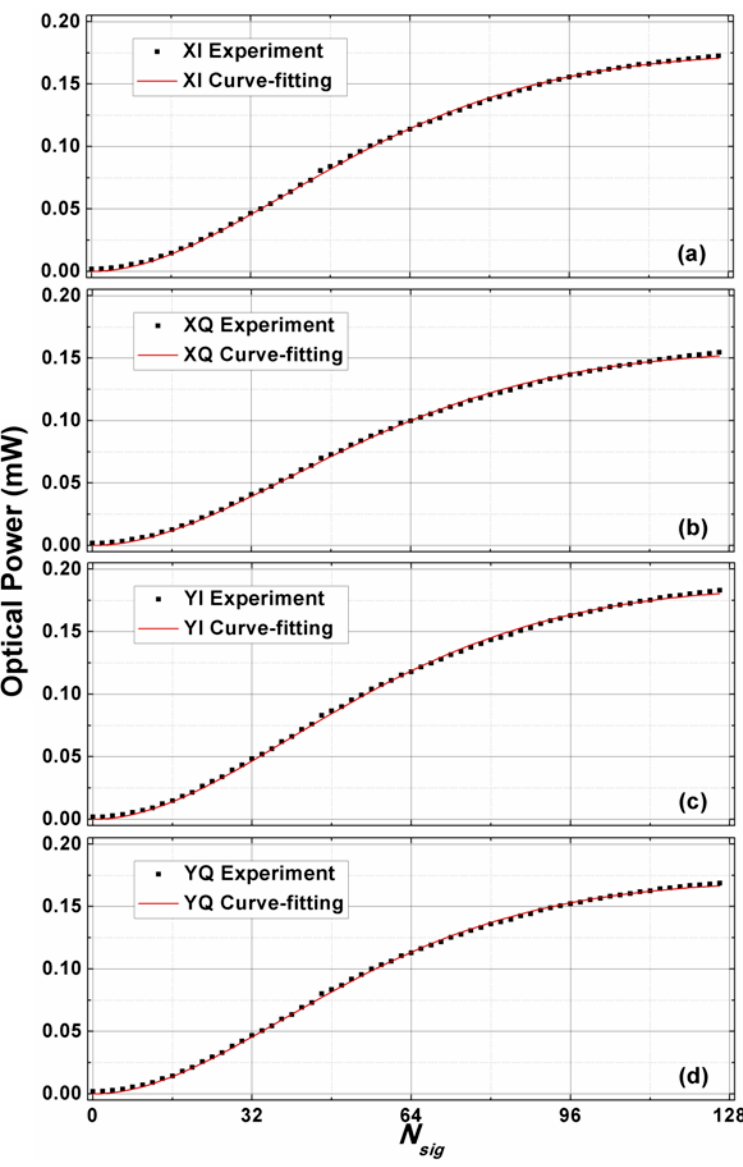
Figure 2. Measurement results versus theoretical analysis for four tributaries. ω =3.77 GHz. Table 1. Fittings parameters for four tributaries.